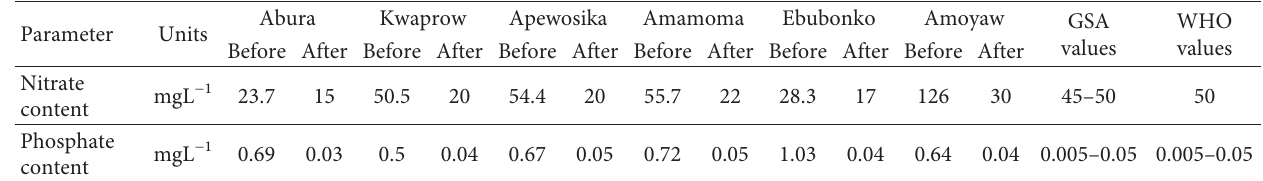
Table 2: The percentage reduction in the concentration of water samples from the communities. Parameter